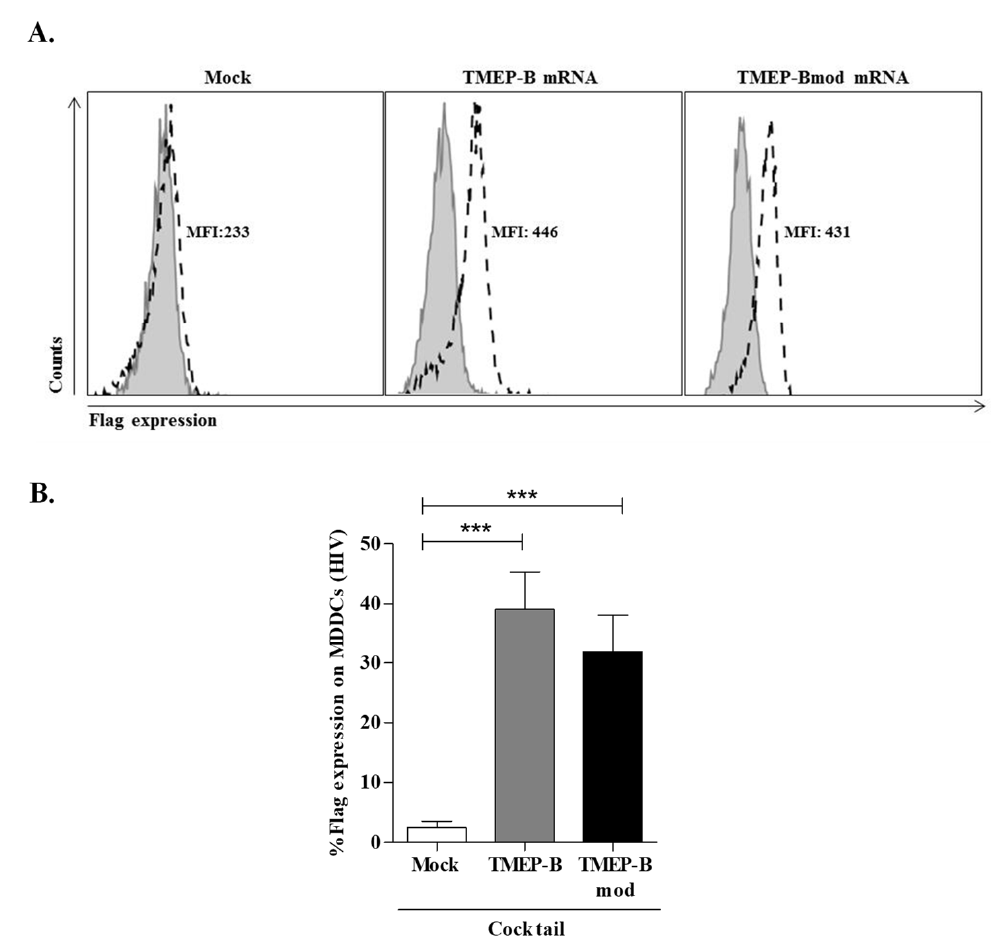
Figure 2. FLAG expression analysis on DCs from HIV infected patients transfected with TMEP-B or TMEP-Bmod mRNA by flow cytometry. DCs were electroporated with 10 µ g of TMEP-B or TMEP- Bmod. Mock transfected cells were used as a negative control. At 24 h post-transfection, cells were collected and processed for flow cytometry analysis. FLAG expression was analyzed using 5 µ g/mL of monoclonal antibody anti-FLAG M2. ( A ) Histogram showing the mean fluorescent intensity (MFI) in a representative experiment. FLAG expression was determined on Mock transfected cells and DCs transfected with TMEP-B and/or TMEP-Bmod. ( B ) Percentage of FLAG expression on DCs